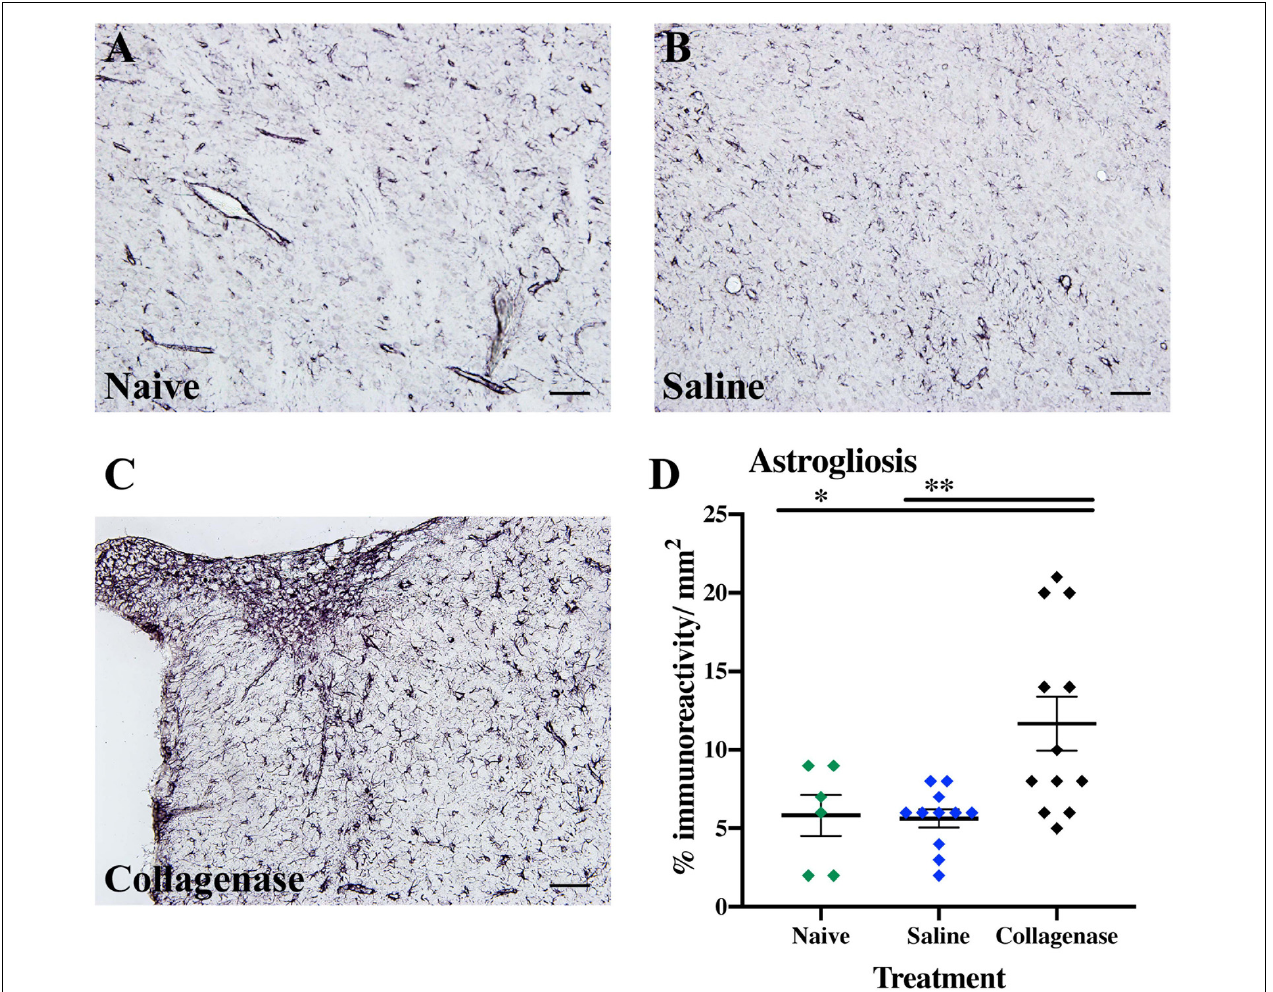
FIGURE 7 | GMH induces astrogliosis at P16. (A) Representative micrograph of GFAP staining in the ipsilateral striatum of naïve ( n = 10), (B) saline ( n = 10), and (C) collagenase ( n = 12) groups at P16. (D) Corresponding graph showing increase in GFAP immunoreactivity in the collagenase-injected group at P16. Data represented as individual animals ± SEM and analyzed using one-way ANOVA followed by Tukey’s multiple comparison test. ∗ P < 0.05 and ∗∗ P < 0.01. Scale bar = 100 µ